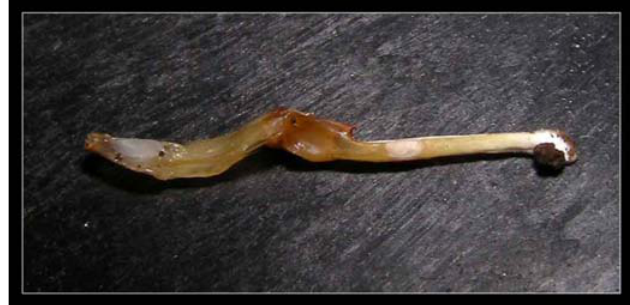
Image 7. Postinsemination spermatophore of H. phipsoni.